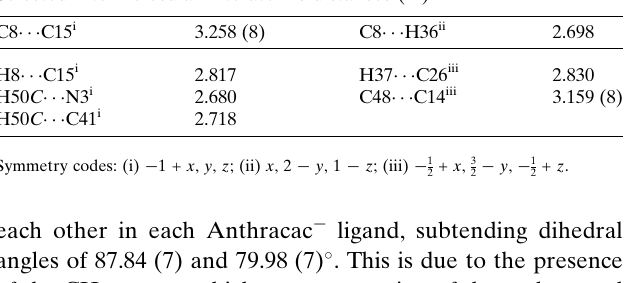
Table 2 Selected intermolecular interatomic distances (A˚ ).